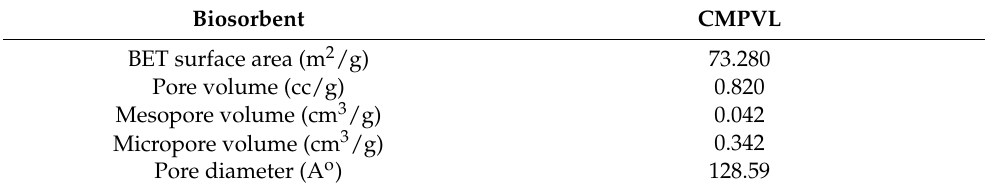
Table 1. Surface parameters of adsorbent.